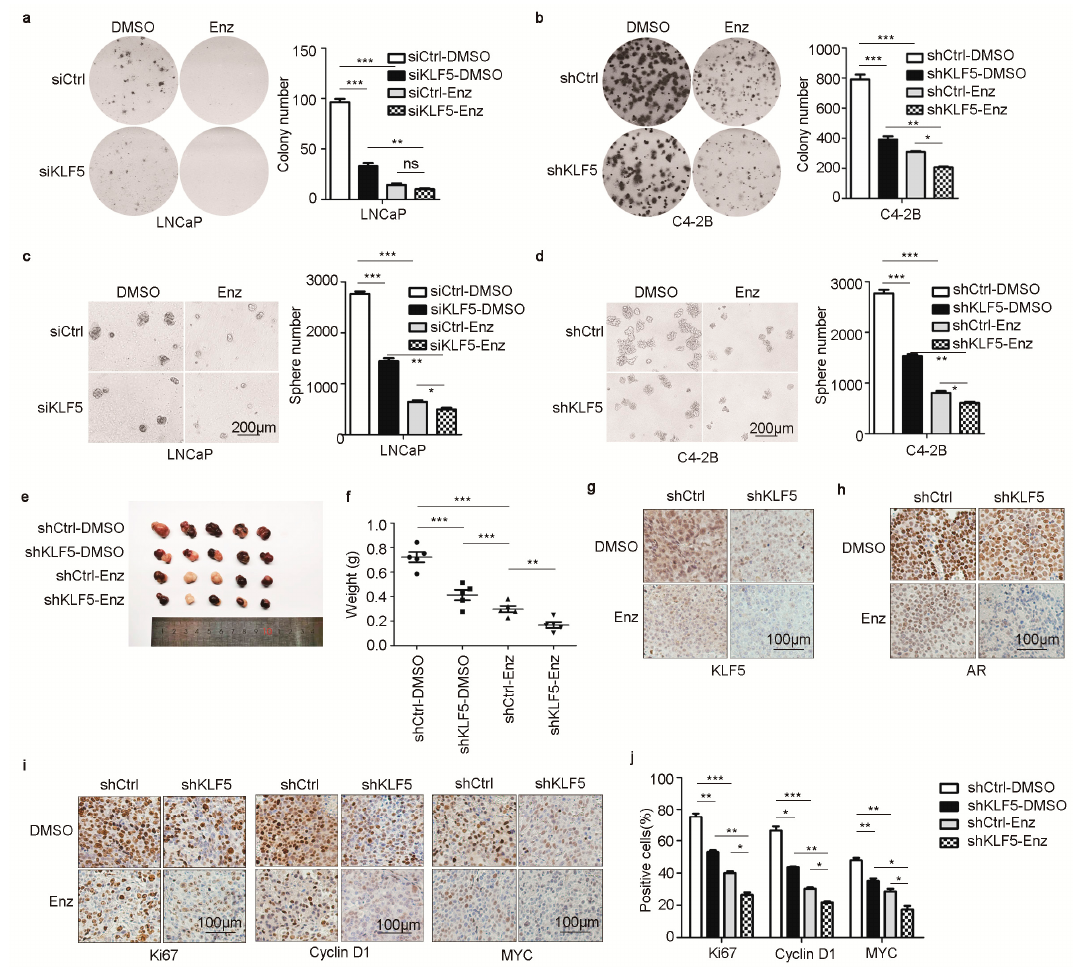
Figure 6. KLF5 is also crucial for androgen / AR signaling to promote cell proliferation and tumor growth in PCa cells. ( a – d ) Knockdown of KLF5 by siRNA in LNCaP cells or by shRNA in C4-2B cells reduced colony forming e ffi ciency in 2-D culture (a, b) and sphere formation in Matrigel (c, d). Cells with KLF5 knockdown were seeded onto 6-well plates at 2000 cells / well for LNCaP and 1000 cells / well for C4-2B in regular medium for colony formation assay, and at 4000 cells / well for LNCaP and 2000 cells / well for C4-2B cells for sphere formation assay. Regular media were used, and enzalutamide (10 µ M) treatment was applied. The culture time was 2 weeks for C4-2B and 3 weeks for LNCaP in both assays. Images of colonies or spheres were taken (left), and their numbers were counted (right). Only spheres with a diameter greater than 80 µ m were counted. Scale bars, 200 µ m. ( e , f ) Knockdown of KLF5 attenuated tumor growth of C4-2B cells in nude mice, as indicated by tumor images (e) and tumor weights at excision (f). ( g , h ) Knockdown of KLF5 reduced AR expression in xenograft tumors of C4-2B cells, as detected by immunohistochemical (IHC) staining with anti-KLF5 (g) and anti-AR (h) antibodies. ( i – j ) Knockdown of KLF5 reduced cell proliferation, as indicated by the Ki67 index, and the expression of cyclin D1 and MYC in tumor xenografts of C4-2B cells, as detected by IHC staining (i) and quantitation of positive cells (j). Scale bars, 100 µ m. ns, not significant; *, p < 0.05; **, p < 0.01; *** p <